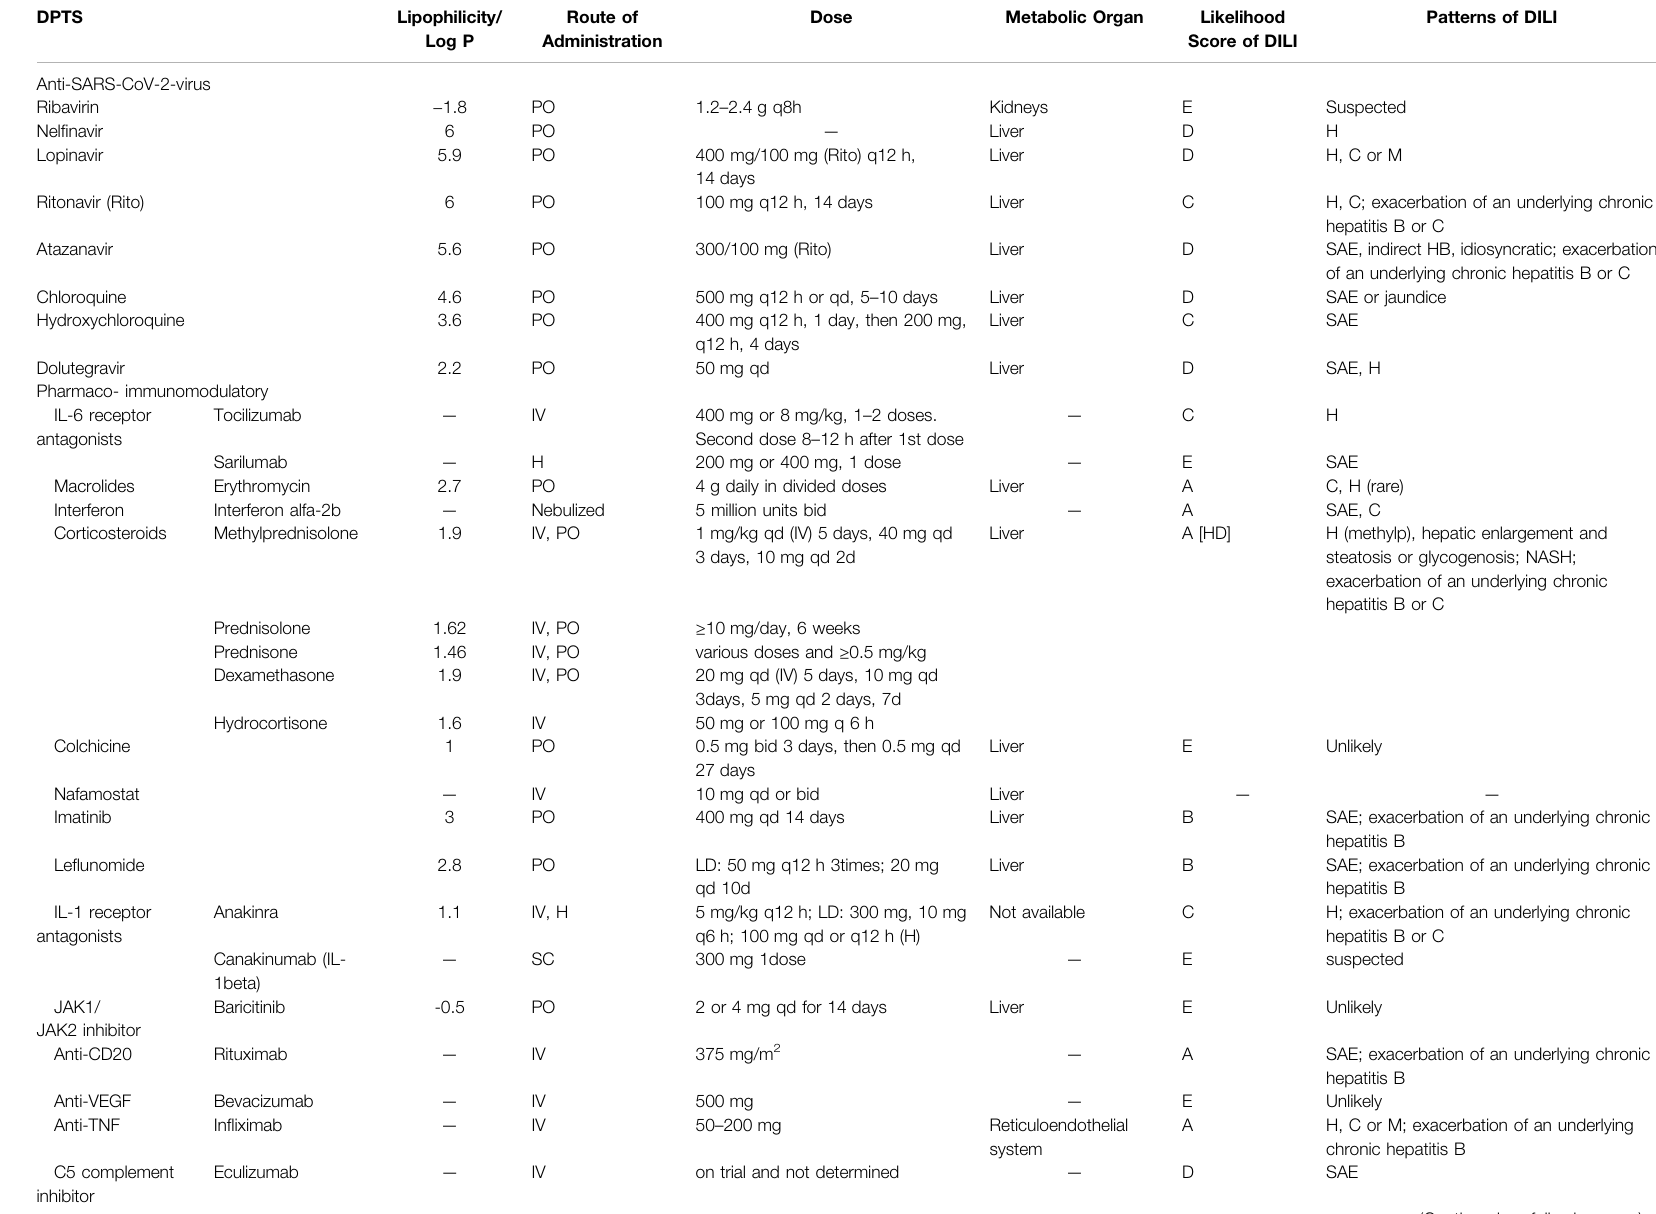
TABLE 4 | Lipophilicity, route of administration, dose, and hepatotoxicity of drugs associated with in fl ammatory targets of cluster 1 , PXR, PPARA, NRF2, and HLA targets. DPTS